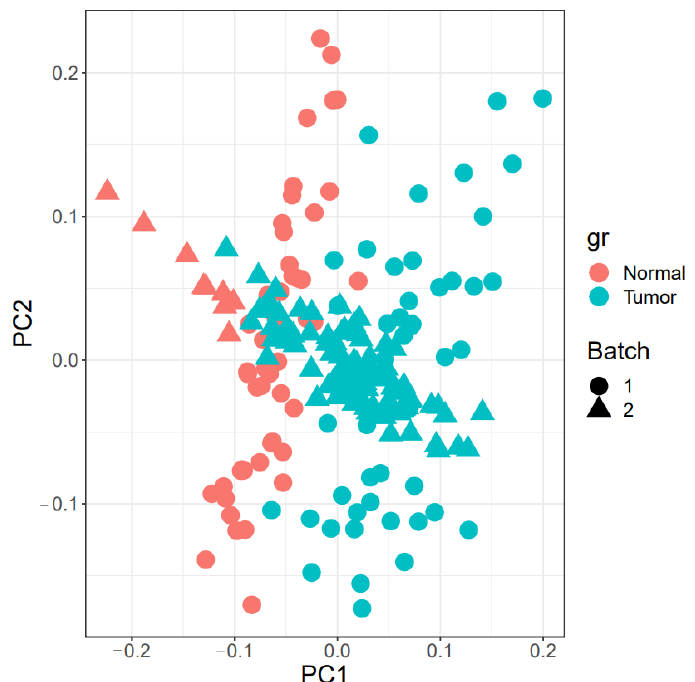
Figure 3. PCA plot. The batch implies that there are two platforms in the data. In addition, two groups of normal and tumor samples were created.